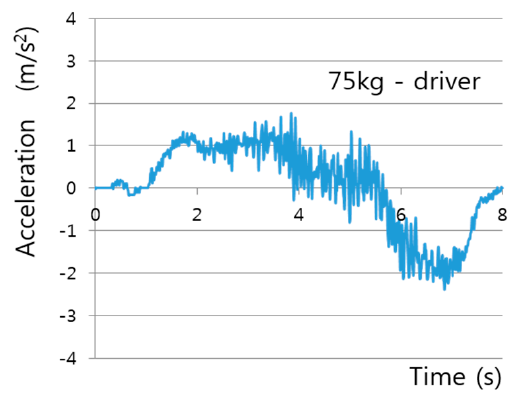
Figure 11. Acceleration data during wheelchair driving test.